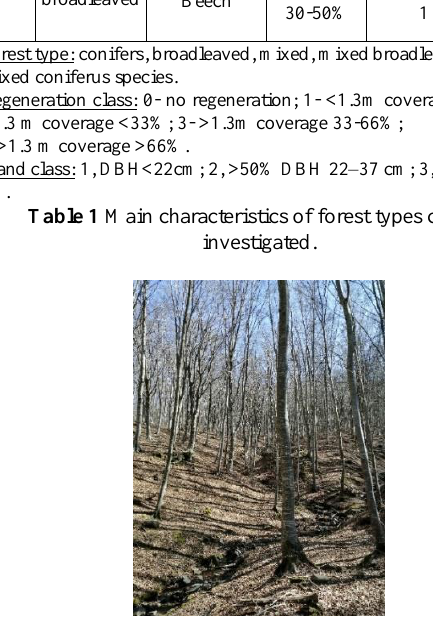
Figure 1.e Turkey Oak forest, plot